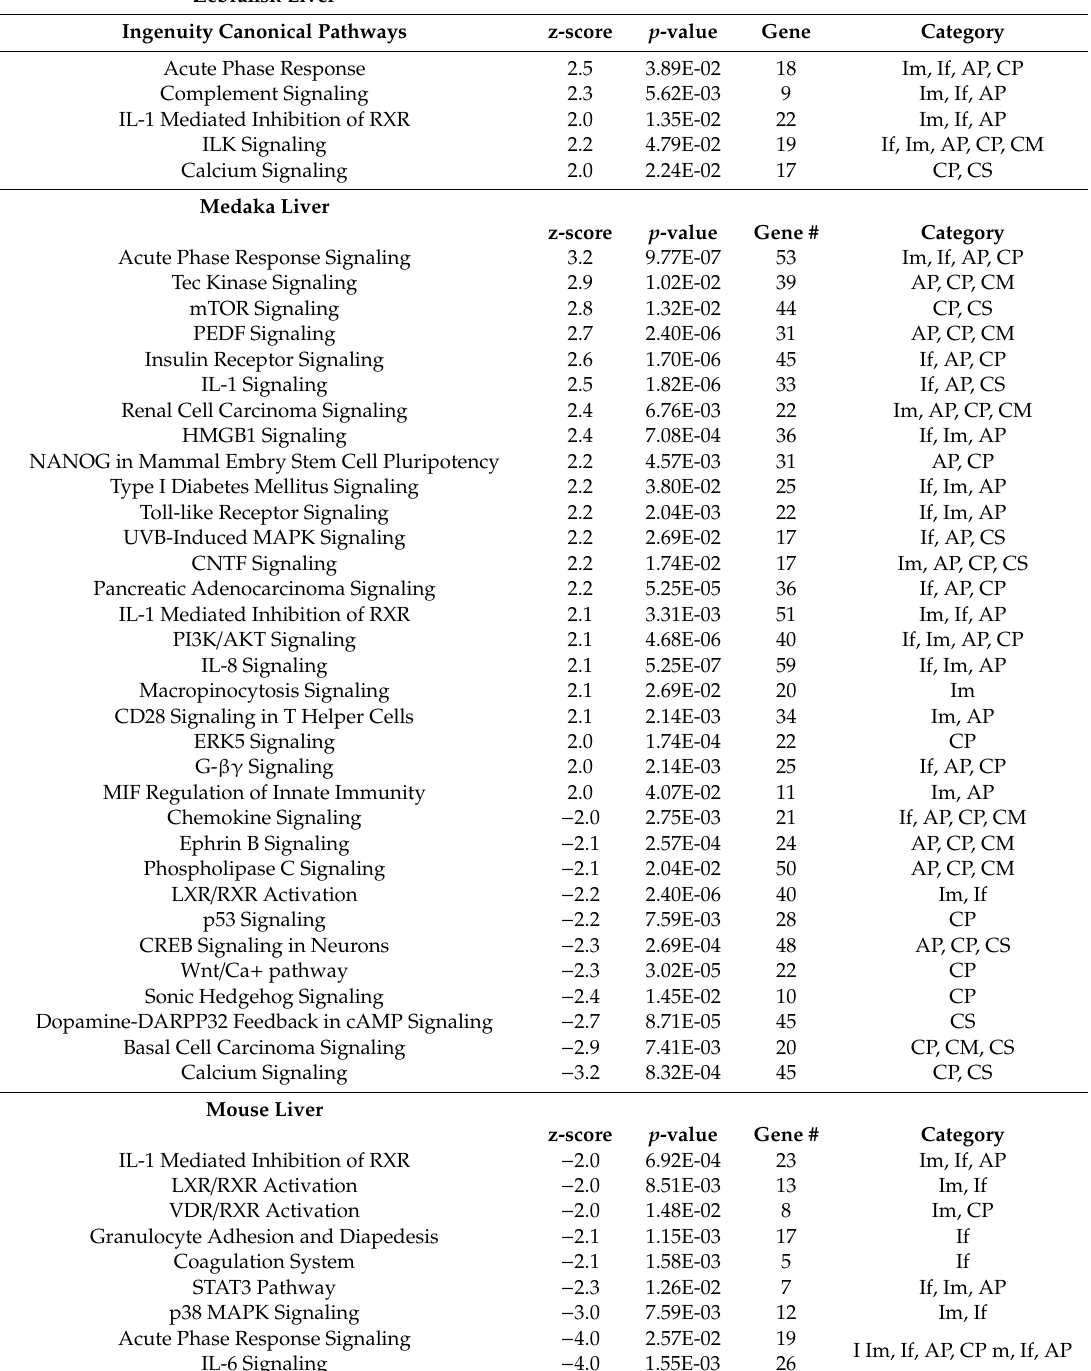
Table 4. Modulated canonical pathways were predicted using IPA for zebrafish (top), medaka (middle), and mouse (bottom) liver. All pathways with a z-score ≥ | 2 | , p -value < 0.05, and five or more genes were included in the analysis. The column on the far right indicates if the pathway is involved an immune (Im), inflammatory (If), acute phase (AP), cellular proliferation (CP), or cellular signaling (CS)